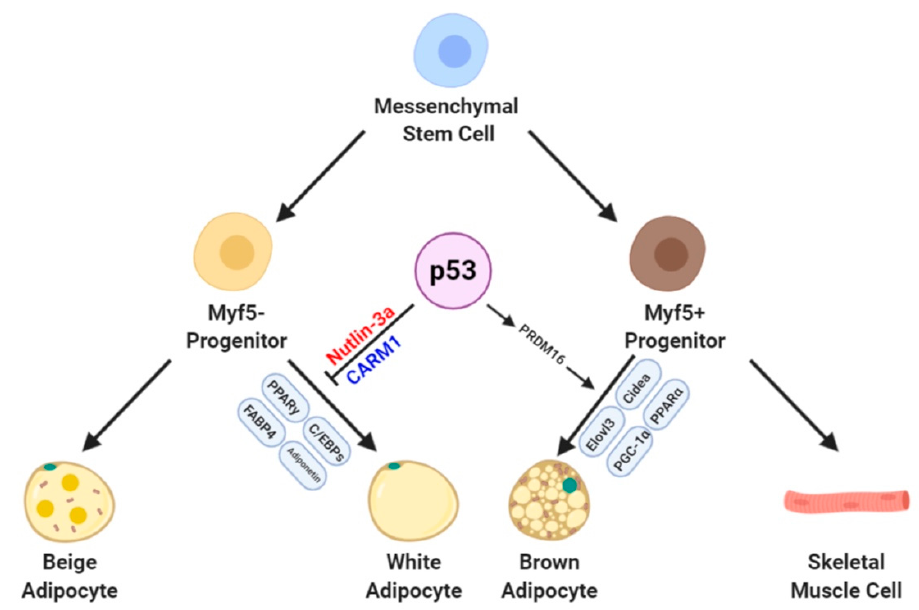
Figure 1. Proposed hypothetical model of the transcriptional role of p53 in white and brown adipogenesis.